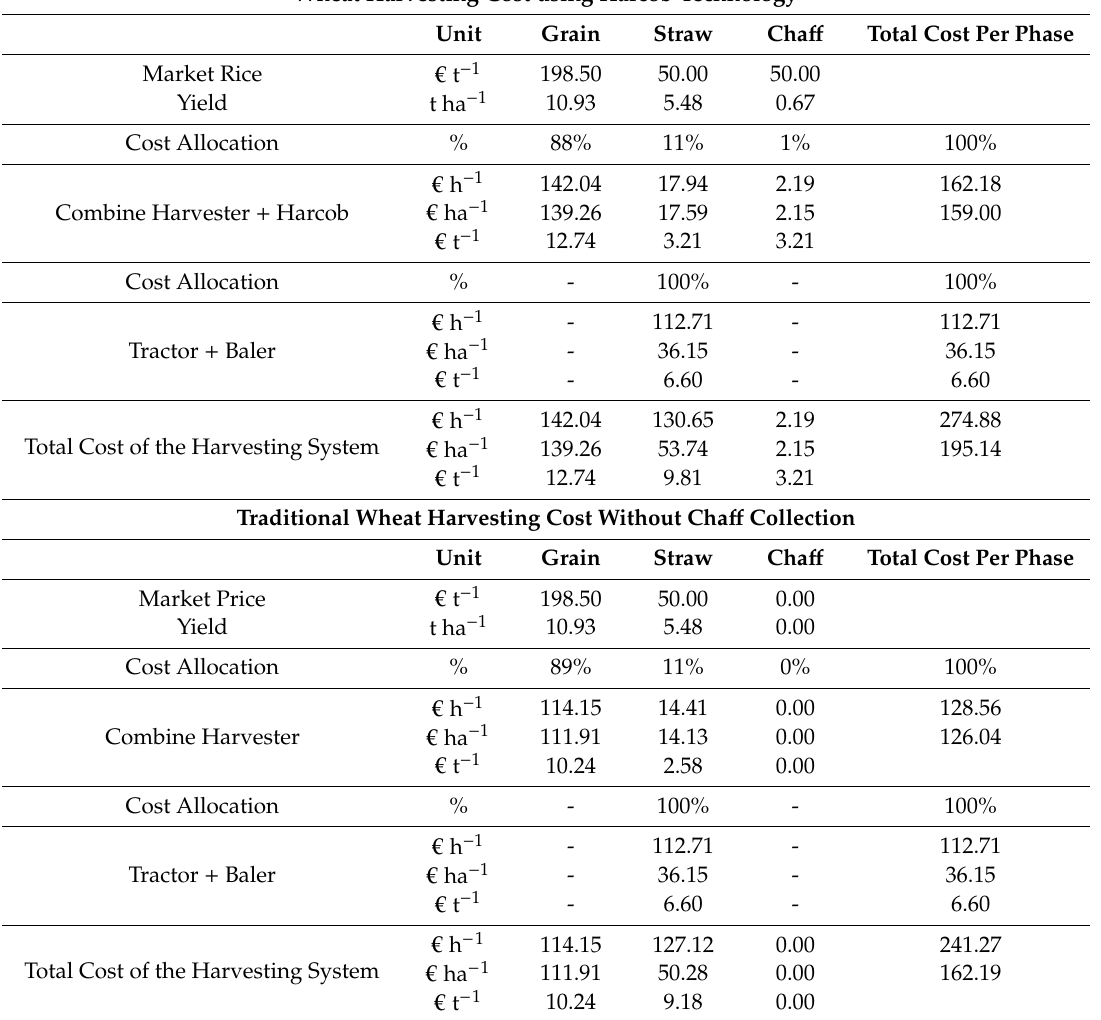
Table 8. Operating costs of wheat grain and residues harvesting. Comparison between traditional and Harcob